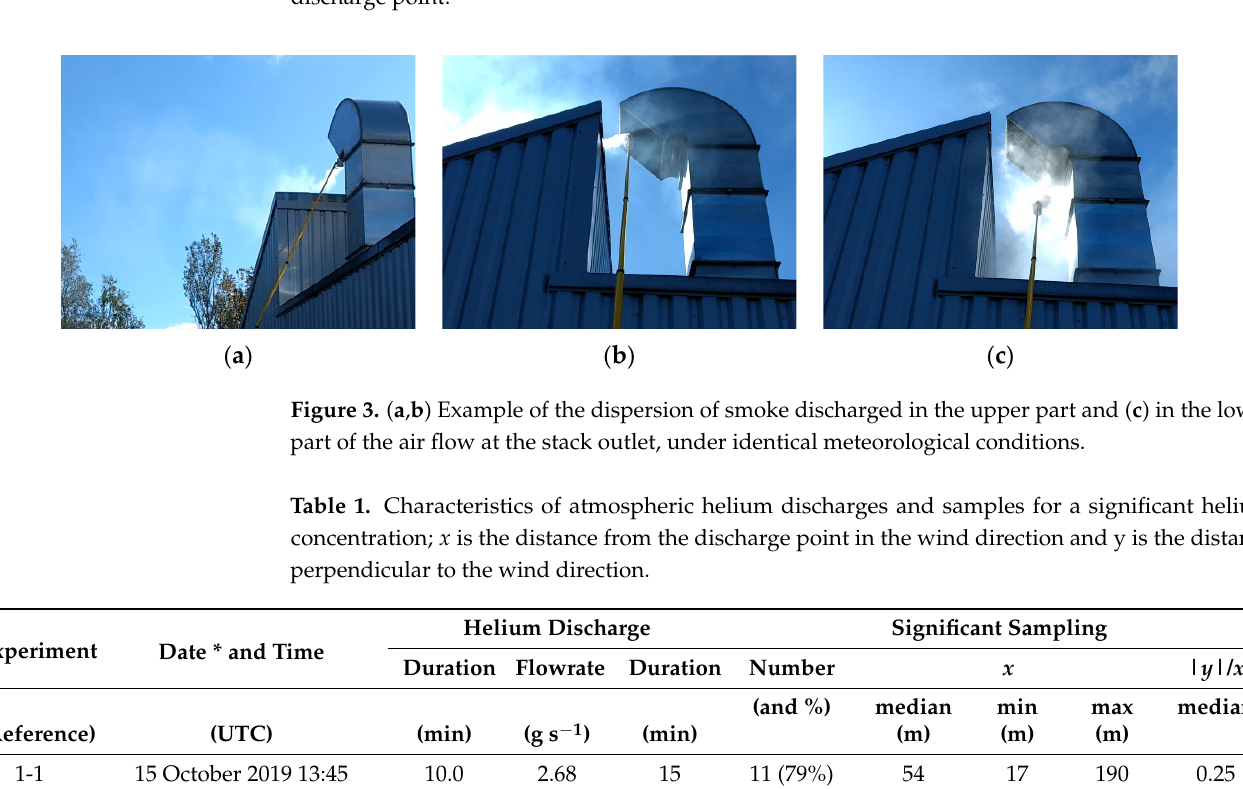
centration; is the distance from the discharge point in the wind direction and y is the distance perpendicular to the wind direction.